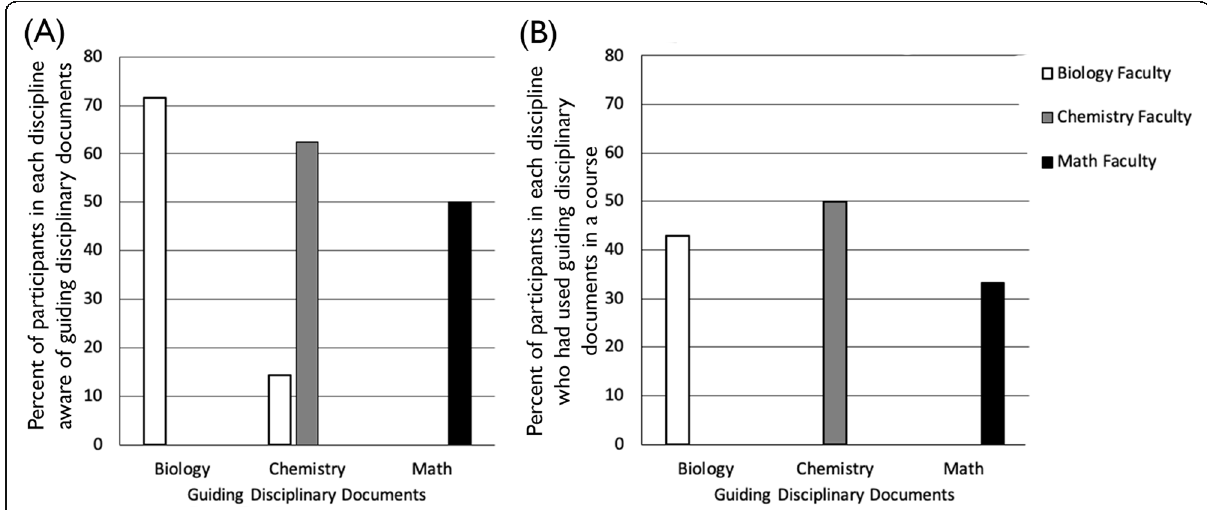
Fig. 4 (STEM) 2 Network Participants ’ Awareness and Use of Guiding Documents. Percent of participants in biology ( N = 7), chemistry ( N = 8), and math ( N = 6) who, prior to joining the (STEM) 2 Network, were a aware of guiding documents in each discipline and b had used guiding documents